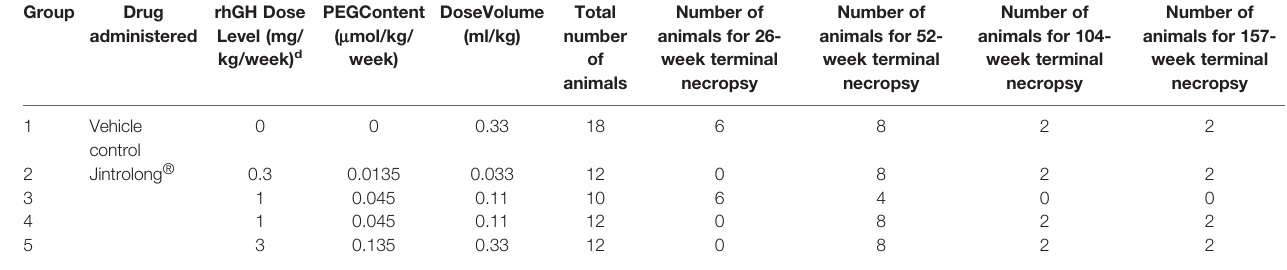
TABLE 1 | Animal grouping and test article dosing information.